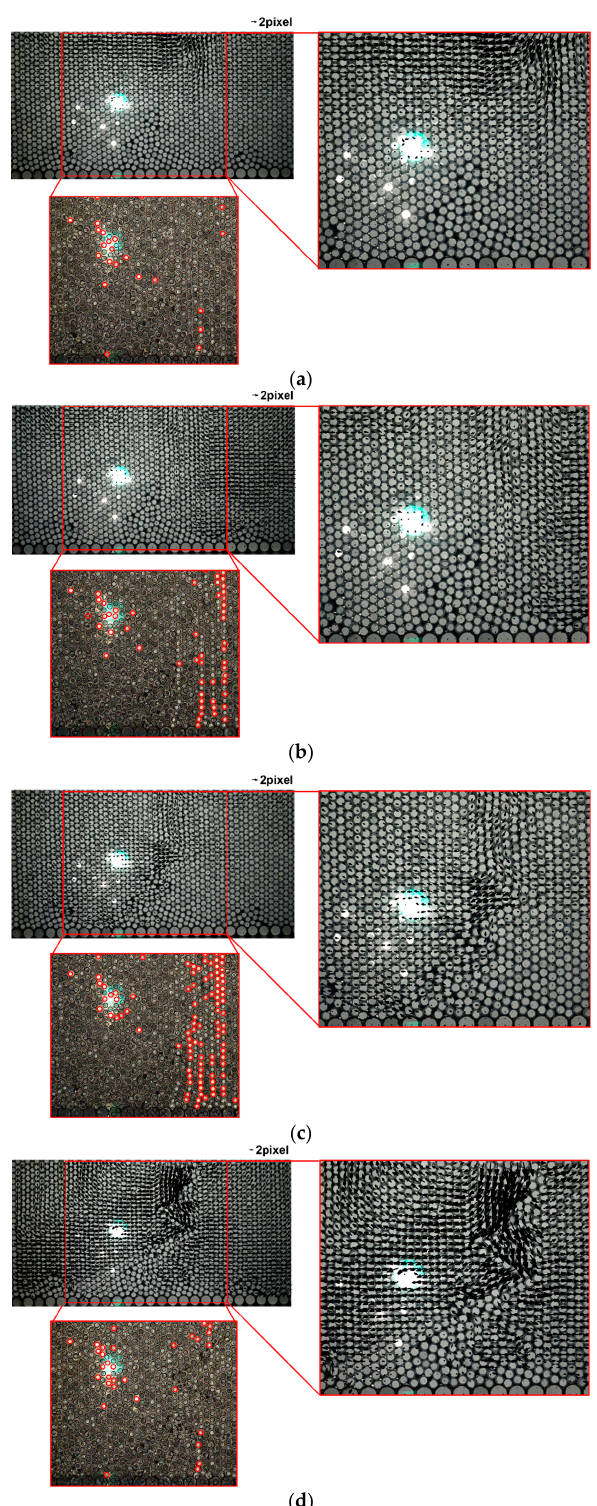
Figure 15. Evolution of imperfections with displacement vectors resulting from particle image velocimetry (PIV) for structures with imperfections under shallow foundation loading: (a) 0–2.57 mm (Figure 13a,b), (b) 3.22–4.00 mm (Figure 13c,d), (c) 4.96–5.29 mm (Figure 13e,f), (d) 5.83–7.81 mm (Figure 13g,h).